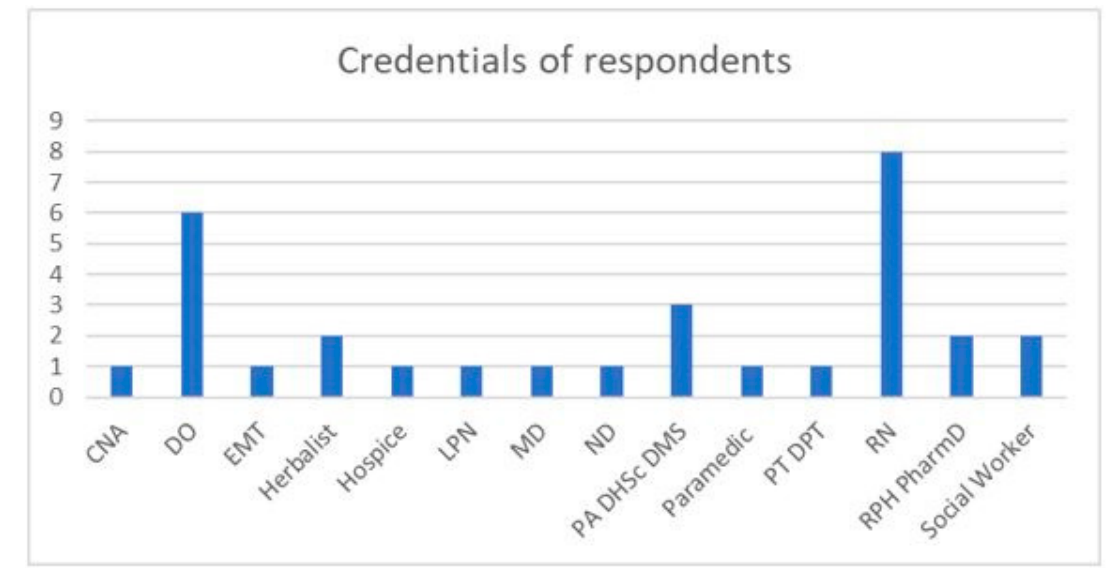
Figure 1. Credentials associated with respondent’s roles in patient interaction. CNA Certified Nurs-